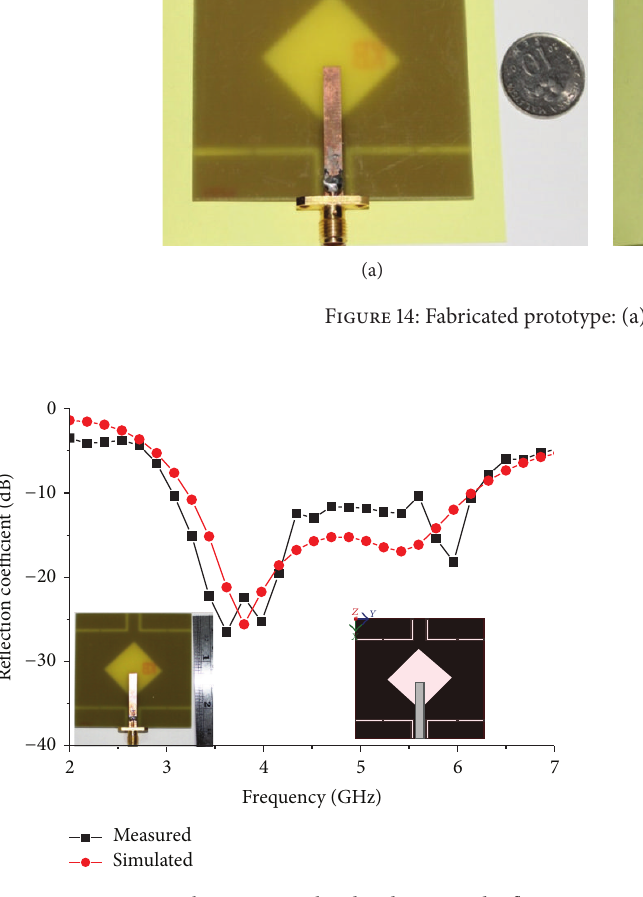
Figure 15: Comparison between simulated and measured reflection coefficient of the proposed antenna.